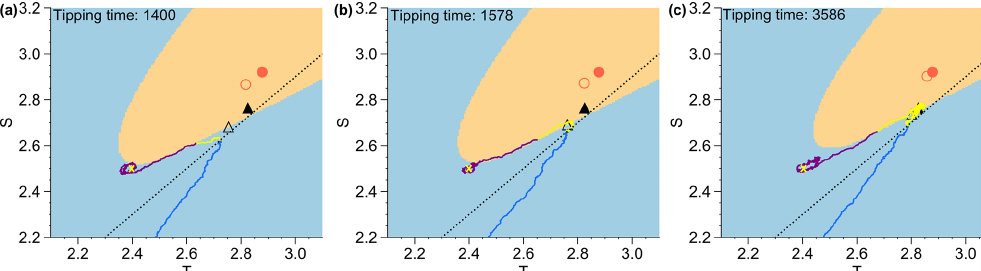
Figure 9. (a–c) Three realizations in phase space of the Stommel model with σ T = σ S = 0 . 2, where η 1 is ramped from η 1 = 2 . 65 to η 1 = 3 . 00 over 300 years. The filled dot (triangle) marks the off fixed point (saddle) at η 1 = 3 . 0. The colored areas are the quasi-stationary basins of attraction at the time when their boundary is first crossed. The colored basins of attractions are given at the time of first basin crossing of the trajectories, which change color from purple to yellow. The initial conditions T,S = (2 . 4 , 2 . 5) are indicated by the yellow cross. The locations of the saddle point (triangle) and the on fixed point at this time are shown with open symbols. The threshold q = T − S = 0 . 1 used to define the time of tipping is shown as a dotted